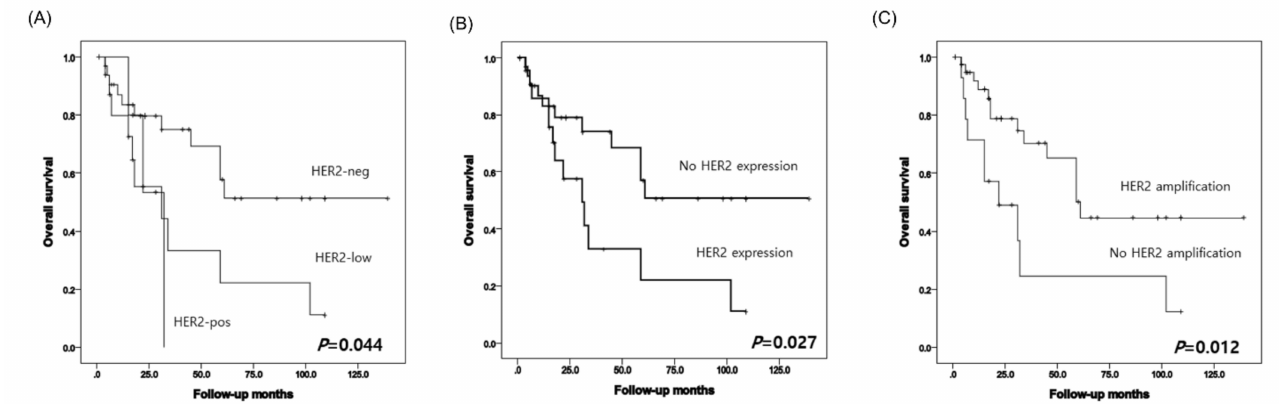
Figure 2. Kaplan-Meier survival analysis. The curve show overall survival differences according to HER 2 expression with three groups ( A ) and HER2 expression ( B ), and gene amplification status by HER2/CEP17 ratio ( C ).